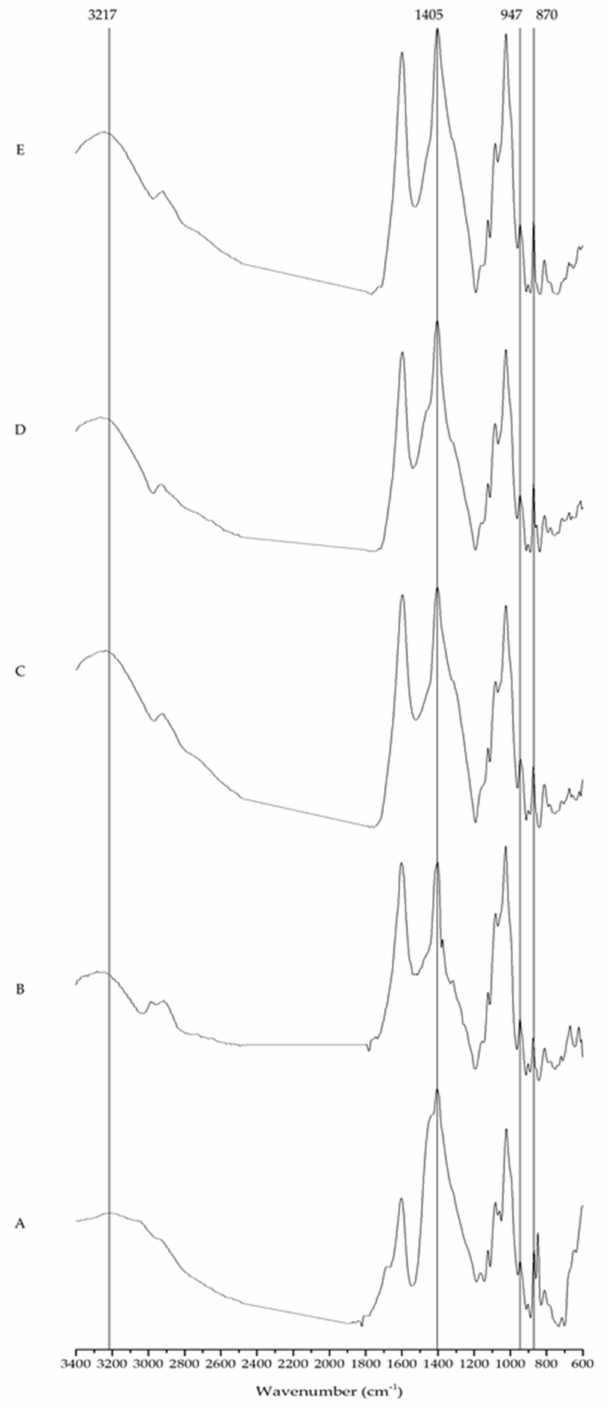
Figure 4. FTIR spectrum of sodium alginate isolated from five brown macroalgae: P. boergesenii ( A ), T. triquetra ( B ), H. cuneiformis ( C ), D. ciliolata ( D ), and S. aquifolium ( E